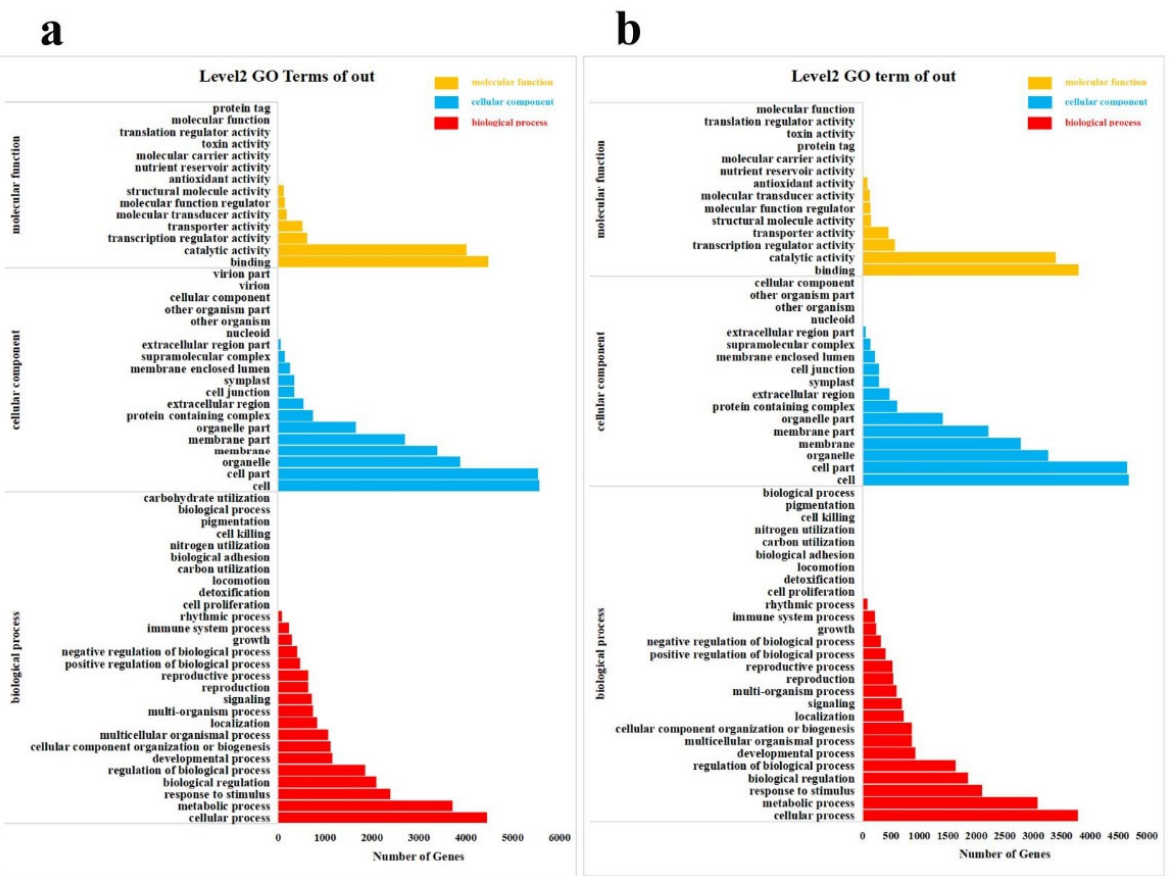
Figure 5. GO classification of DEGs. ( a ) Leaves; ( b ) Roots. The x − axis is the number of genes in the annotation, and the y − axis represents GO categories of gene function.